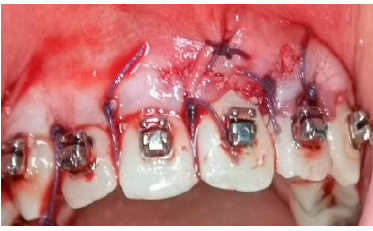
Figure 4. Sutures after the flap reposition.